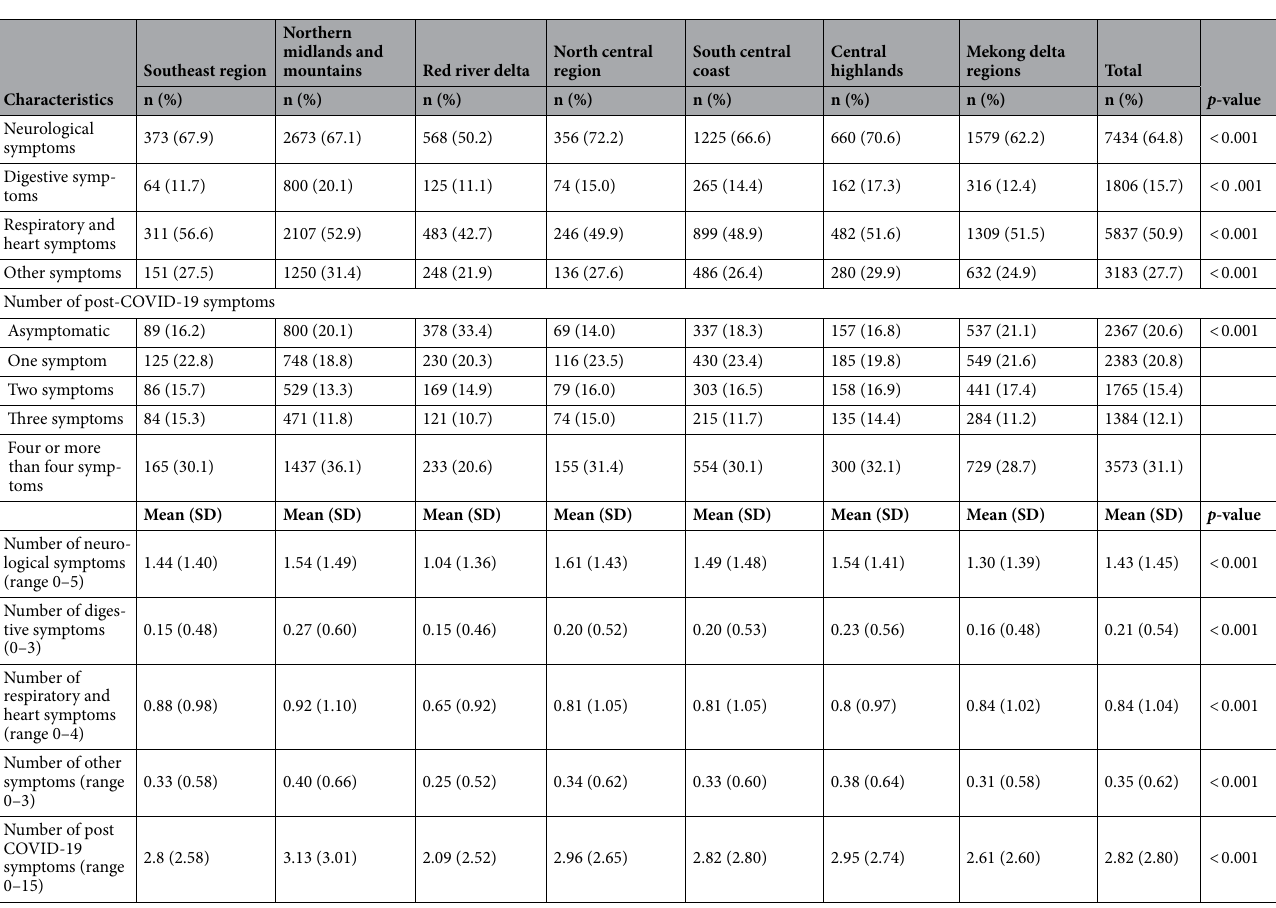
Table 3. Characteristics of post-COVID-19 symptoms by